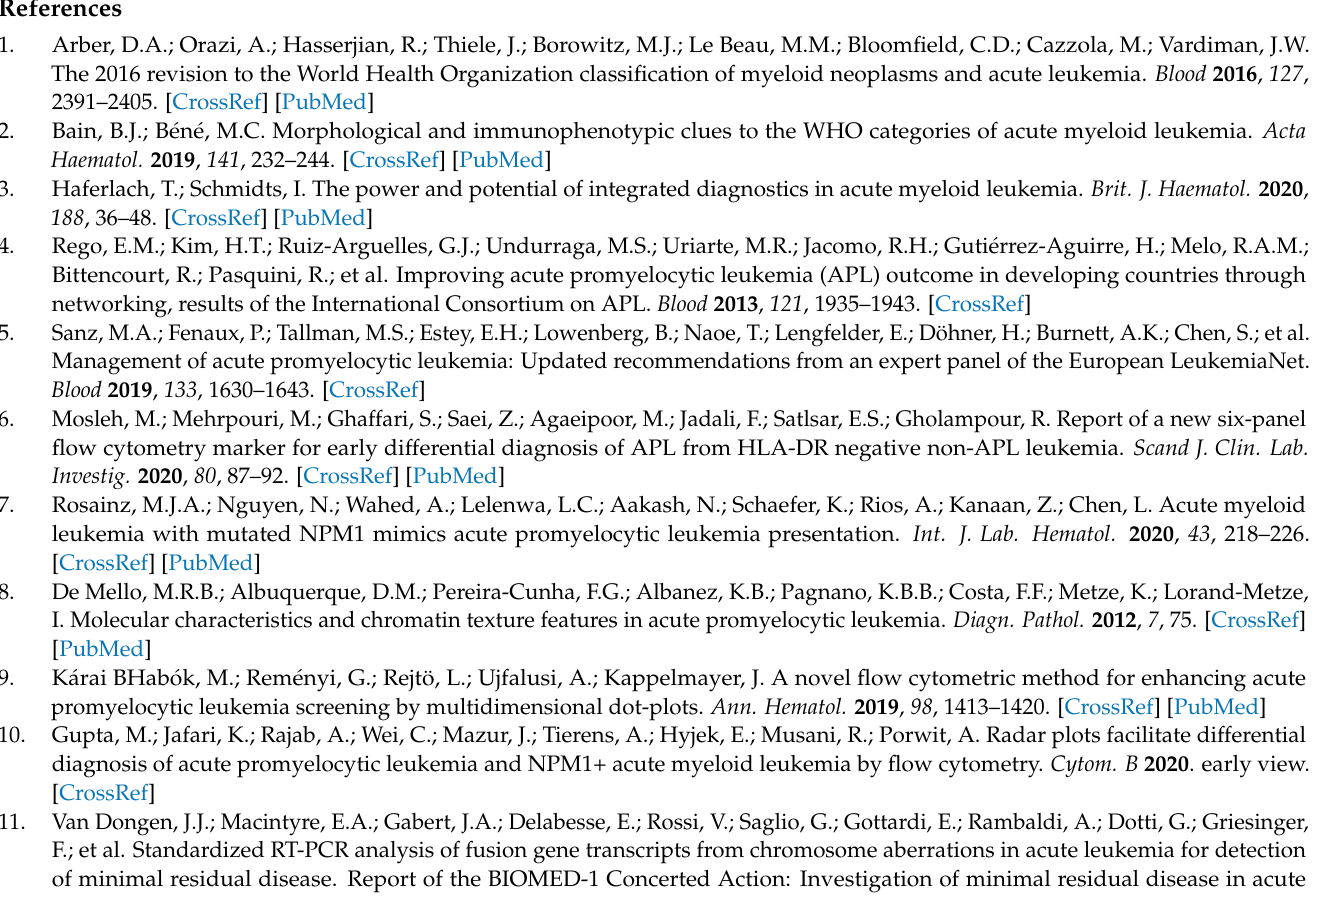
Table S2: Antibody